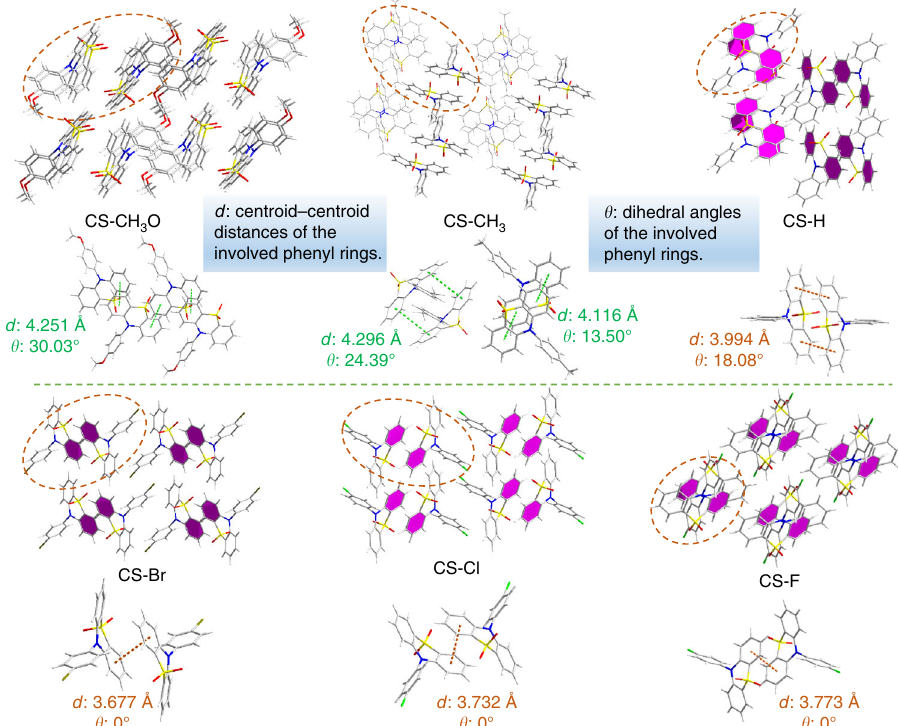
Fig. 3 Single-crystal structures of the six target compounds. Entire and local packing modes of the crystals for CS-CH 3 O, CS-CH 3 , CS-H, CS-Br, CS-Cl, and CS-F: the local packing pictures were selected from the parts in cycles of corresponding entire ones, in which the centroid – centroid distances and the dihedral angles of the involved phenyl rings are listed and the phenyl rings involved in the stronger π – π interactions in entire are labeled by pink